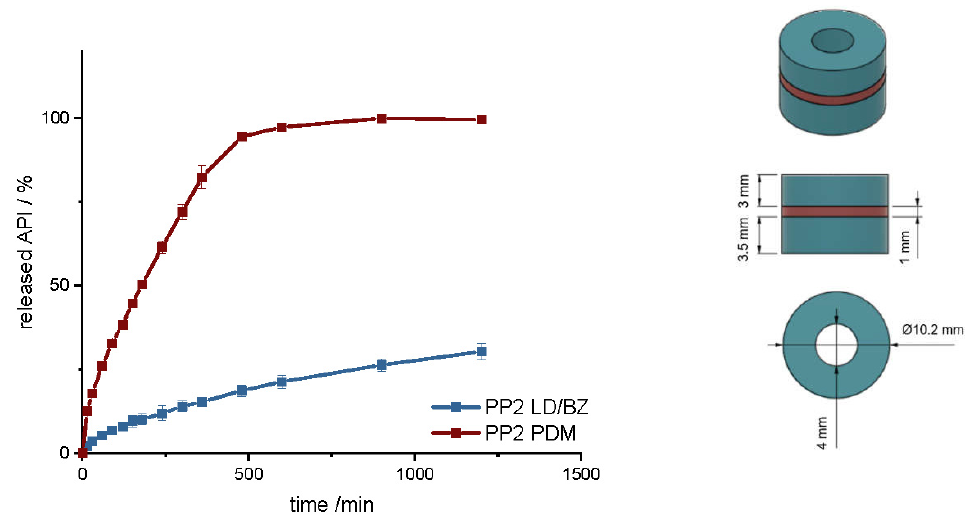
Figure 8. ( Left ): release profile of PP2; modified basket apparatus, 1000 mL 0.1 N HCl, 50 rpm, 37.0 ± 0.5 °C, x ± s; n = 3. ( Right ): Image of PP2: red: PDM-PVA, blue: LD/BZ-EVA.